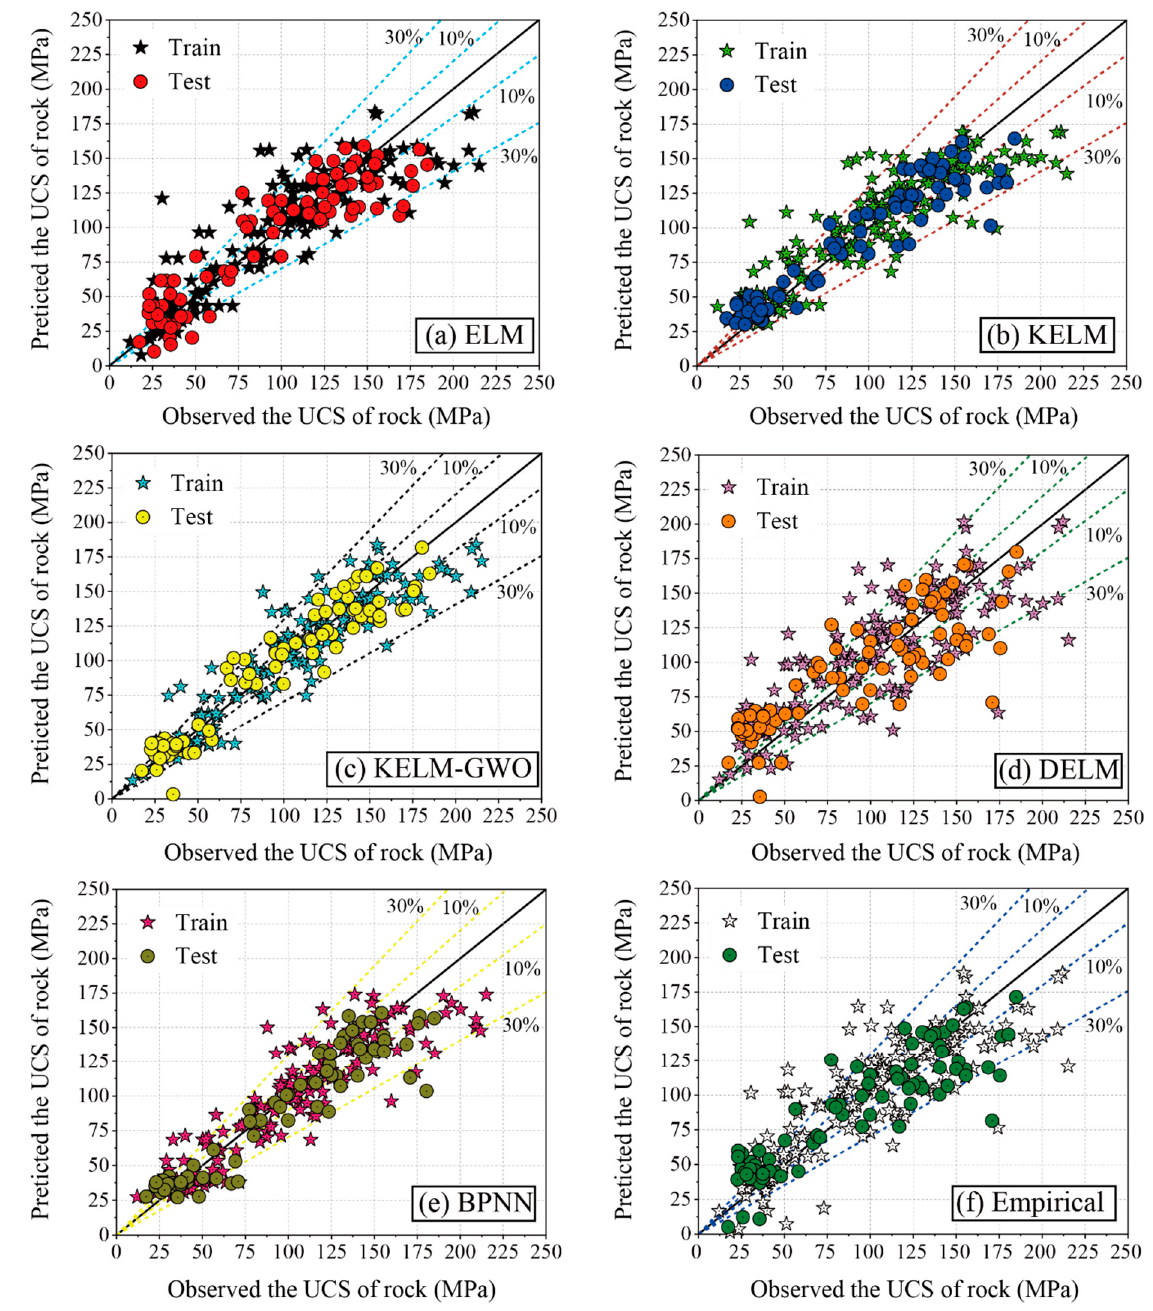
Figure 9. Regression diagrams of the models in the training and testing phases To clearly show the performance of the six models in the training and testing phases, the error histograms were described in Figure 10. The horizontal axis and the vertical axis represent the error between the predicted value and its total percentage (%), respectively. That is to say, increasing the tall error bars close to the origin, increases the prediction accuracy of the model. As can be seen in this figure, the percentage of the lowest error is highest in the KELM-GWO model and the lowest in the DELM model.